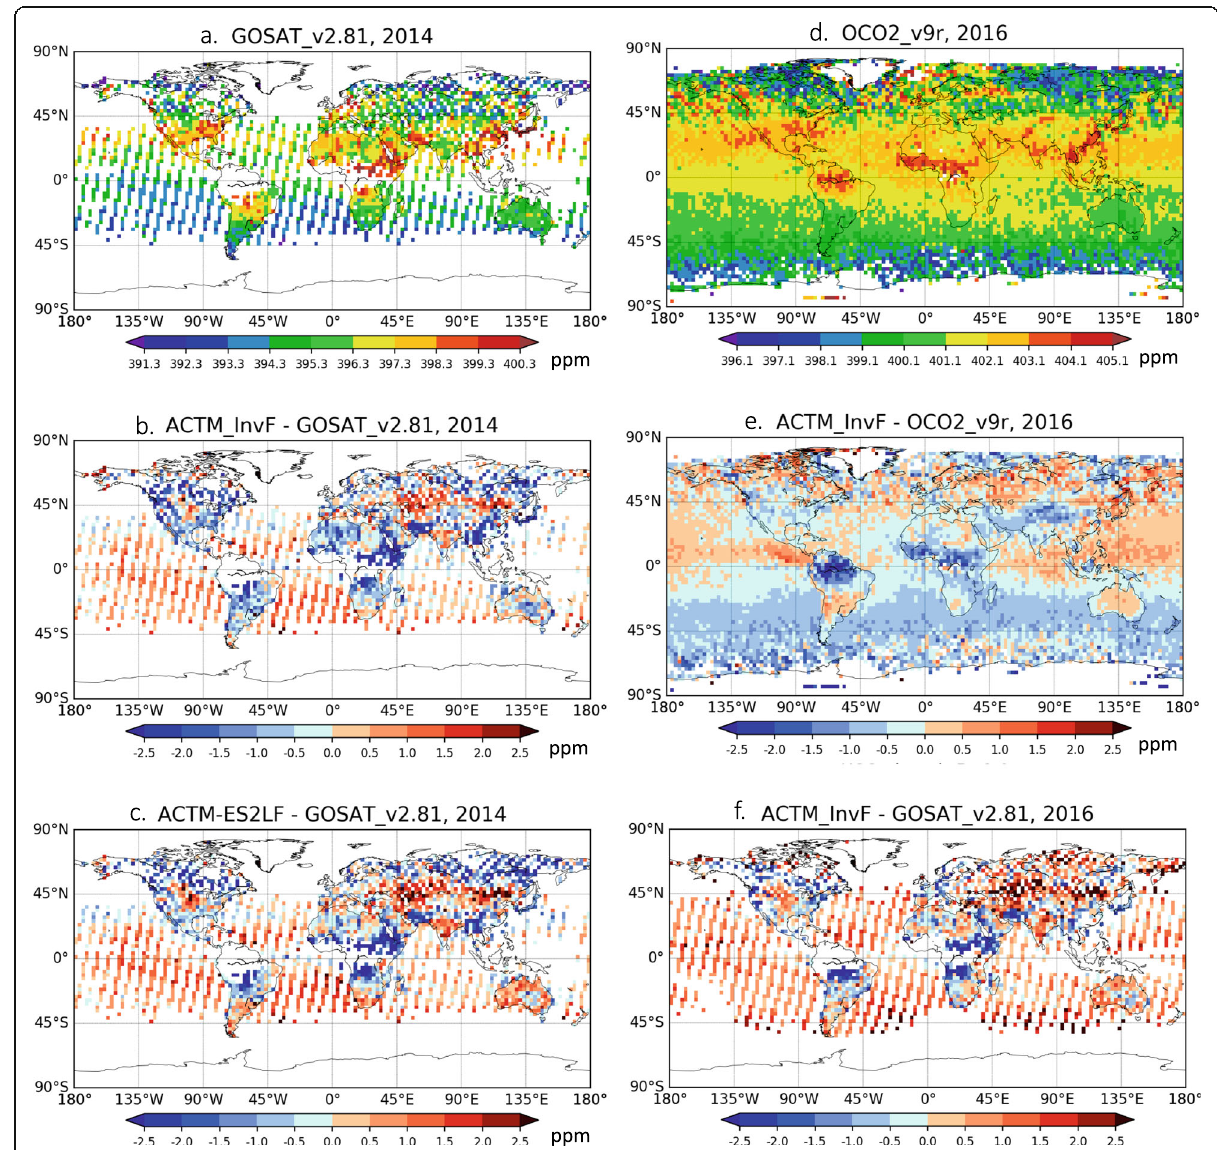
Fig. 4 Spatial maps of XCO 2 for GOSAT only in comparison with ACTM_InvF and ACTM_ES2LF simulations for 2014 (left column), and OCO-2 (and GOSAT) in comparison with ACTM_InvF only for 2016 (right column). Results are shown for a full calendar